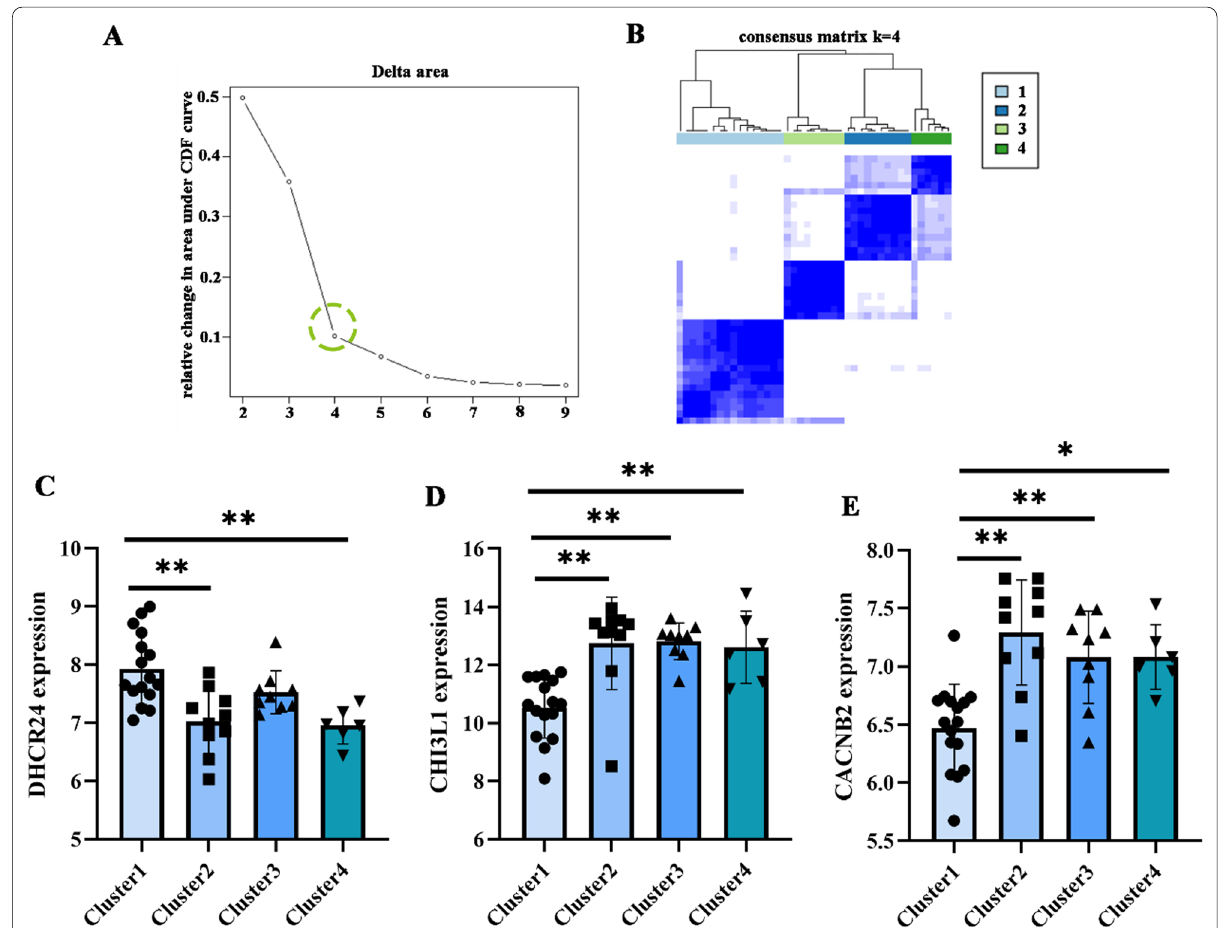
Fig. 2 A , B Grouping the validation dataset based on the expression of DN-related pyroptosis genes; C–E analysis of differential gene expression in different pyroptotic status groups. * P < 0.05; ** P < 0.01;*** P <